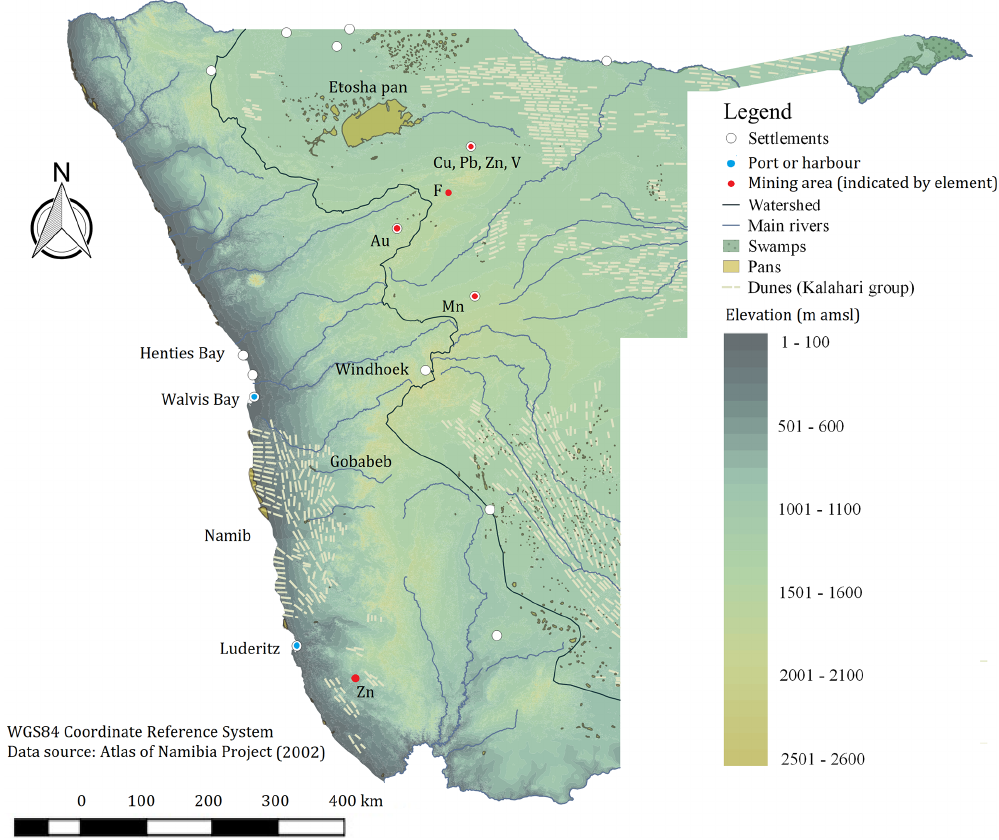
Figure 1. Geographical map of Namibia with elevation as a shaded gradient and some of the known emission sources in the region, such as major urban settlements and airports, harbours, pans and swamps, mineral-rich mining operations, labelled by the major element being mined, and dune fields of the Kalahari stratigraphic group (Atlas of Namibia project,